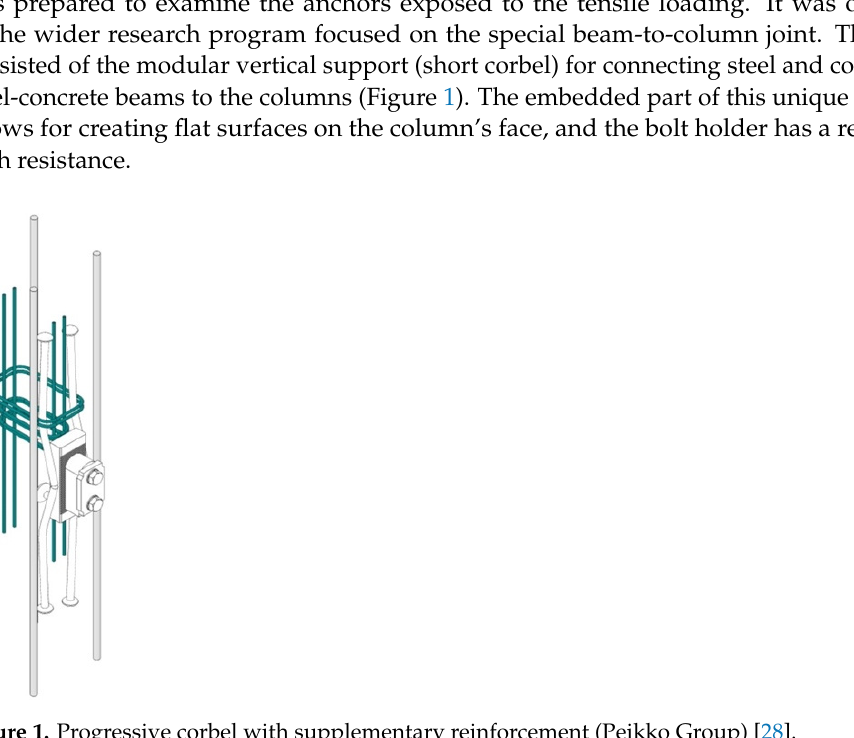
Figure 1. Progressive corbel with supplementary reinforcement (Peikko Group) [28].